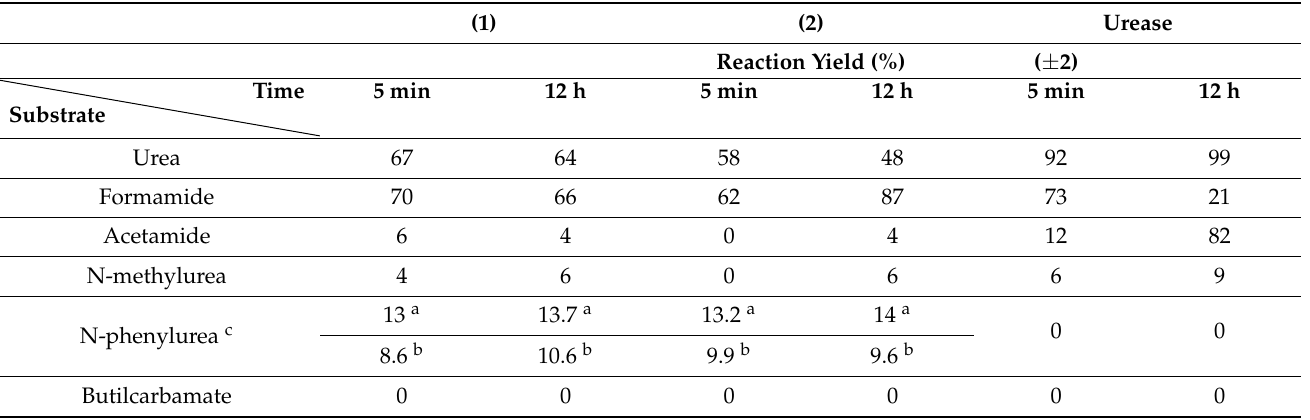
Table 1. Hydrolysis of several substrates by urease (1.6 mM) and the bis-nickel complexes (2.2 mM) at different reaction